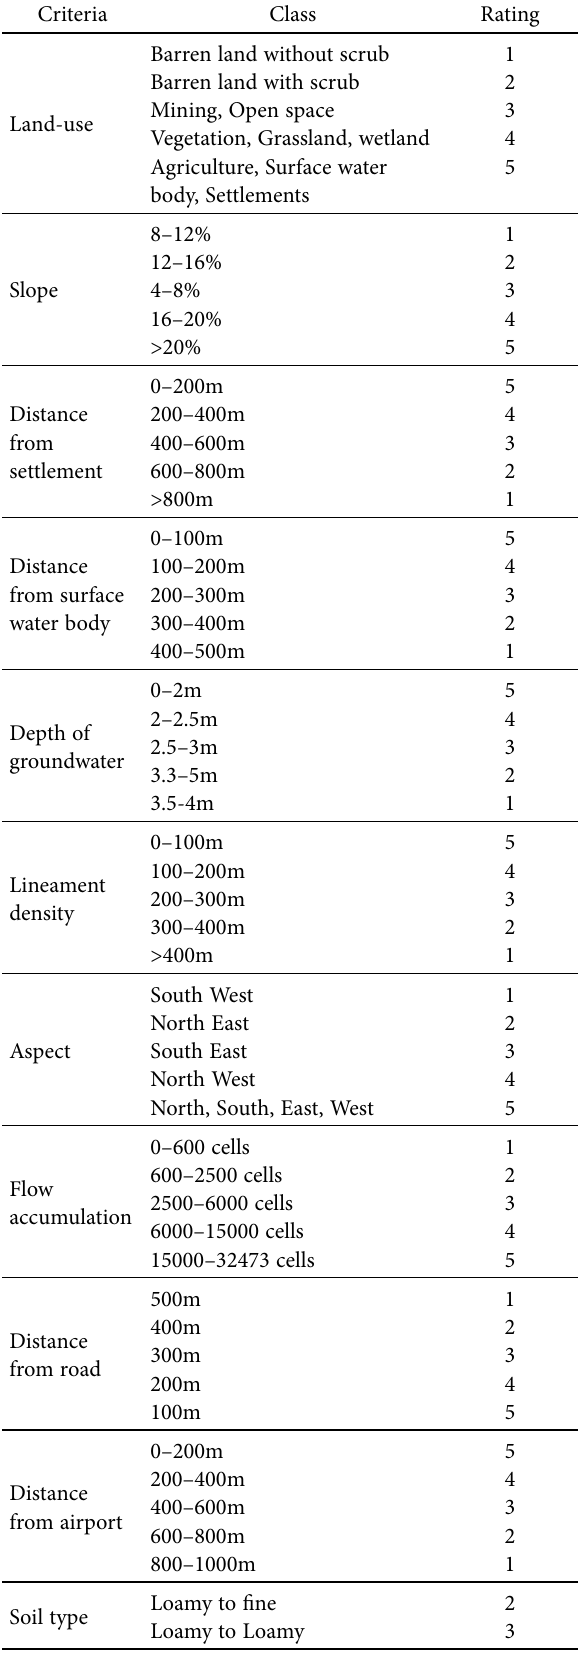
Table 1. Reclassified criteria and their rating Criteria Class Rating Barren land without scrub Barren land with Land-use